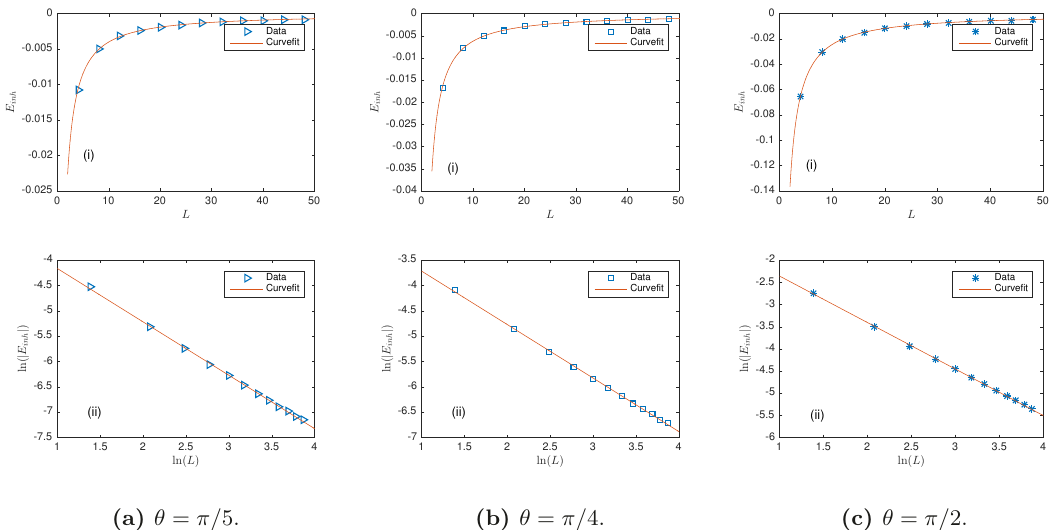
Figure 2. The contribution of the inhomogeneous term to the ground state energy E inh versus the system size L . The data can be fitted as E inh = γL β [or ln( | E inh | ) = p ln( L ) + q ]. Here ξ = − 0 . 1, ζ = 0 . 05, θ ′ = 0, φ = φ ′ = 0, (a) θ = π/ 5, γ = − 0 . 0478 and β = − 1 . 080; (b) θ = π/ 4, γ = − 0 . 0755 and β = − 1 . 087; (c) θ = π/ 2, γ = − 0 . 2871 and β = − 1 . 073. Due to the fact β < 0 [or p < 0], when the L tends to infinity, the contribution of the inhomogeneous term tends to